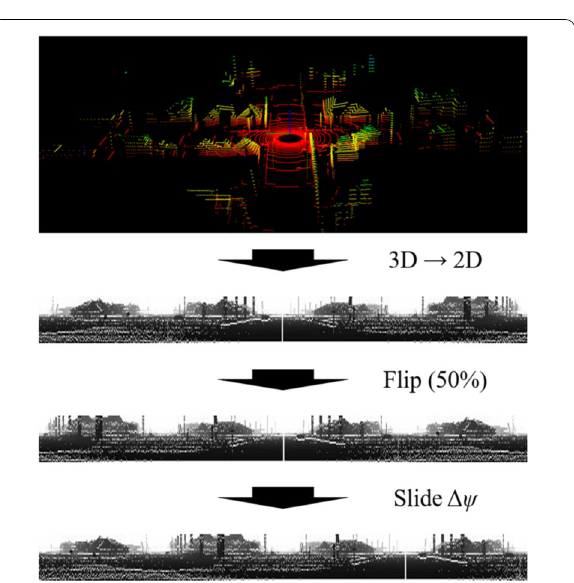
Fig. 4 Preprocessing scheme. Each 3D point cloud is transformed to a 2D depth image. The depth image is randomly flipped and slid. Flipping, rotation, and L2 normalization are also applied to the gravity vector. In this example, the virtual yaw variant is �ψ